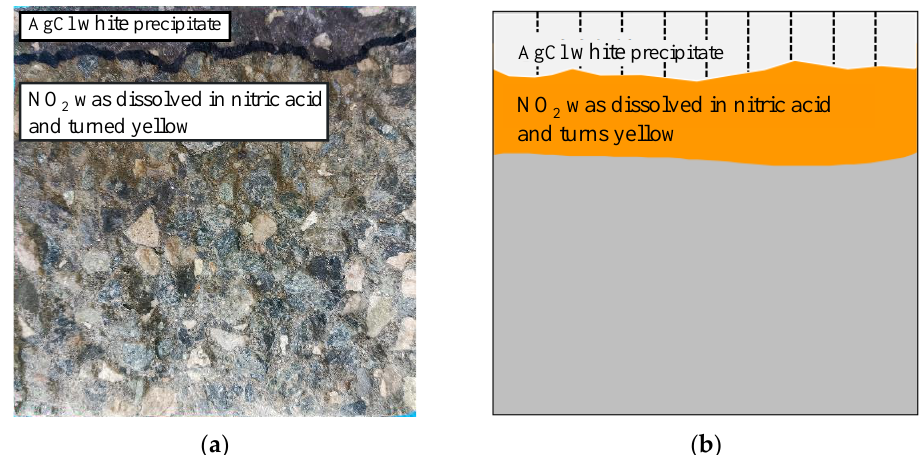
Figure 7. AgNO 3 solution color-rendering test. ( a ). Split surface of corroded specimen. ( b ). Schematic diagram of an equally divided splitting plane.